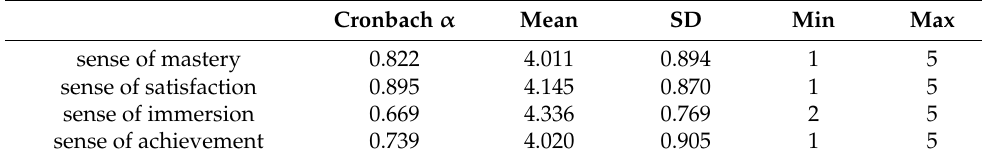
Table 3. Experience score statistics of the dimensions after